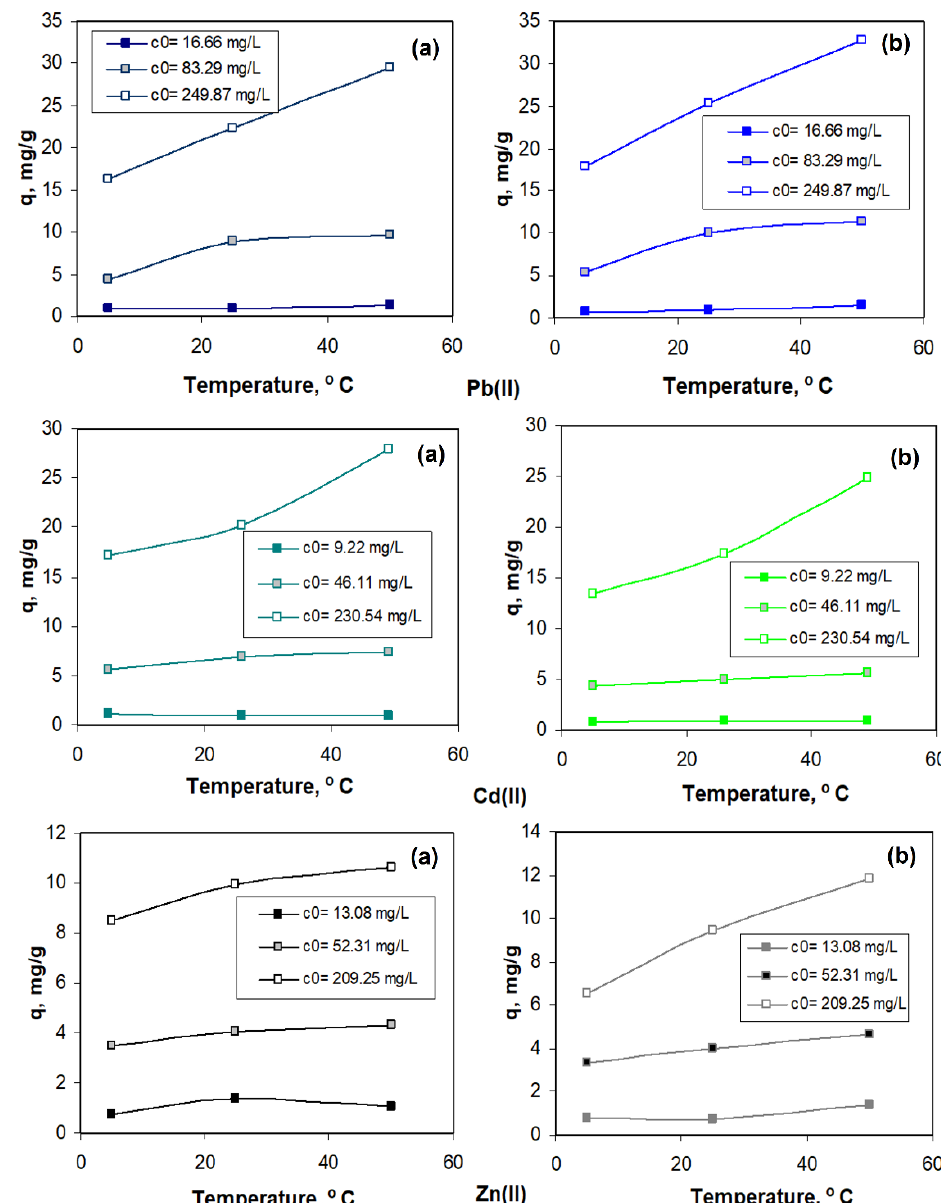
Figure 8. Influence of temperature on the biosorption capacity of soybean biomass ( a ) and soybean waste ( b ) for the retention of the metal ions (pH = 3.39; 5 g biosorbent/L; 3 h).